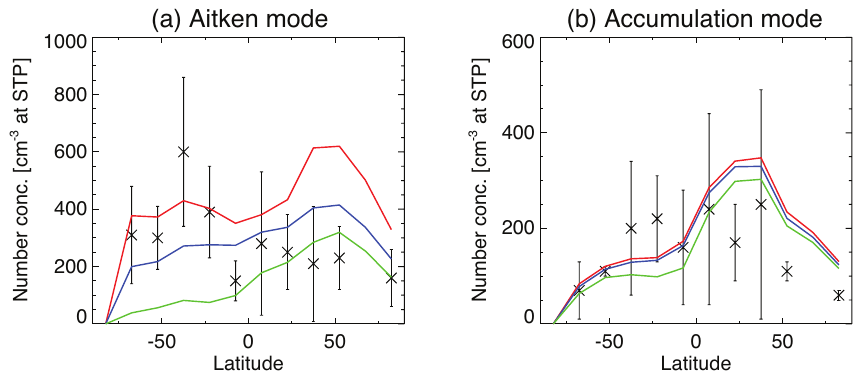
Figure 25. Simulated number concentrations in (a) Aitken mode (10nm ≤ Dp < 100nm) and (b) accumulation mode (100nm ≤ Dp < 1µm) compared to the observations (“x” symbol with error bar representing minimum and maximum observed concentrations) that were compiled and aggregated into 15 ◦ latitude ranges (Heintzenberg et al., 2000). The model is also averaged to the 15 ◦ grid and is shown in red lines for the BASE run, blue lines for the LowNUC run, and green lines for the NoNUC